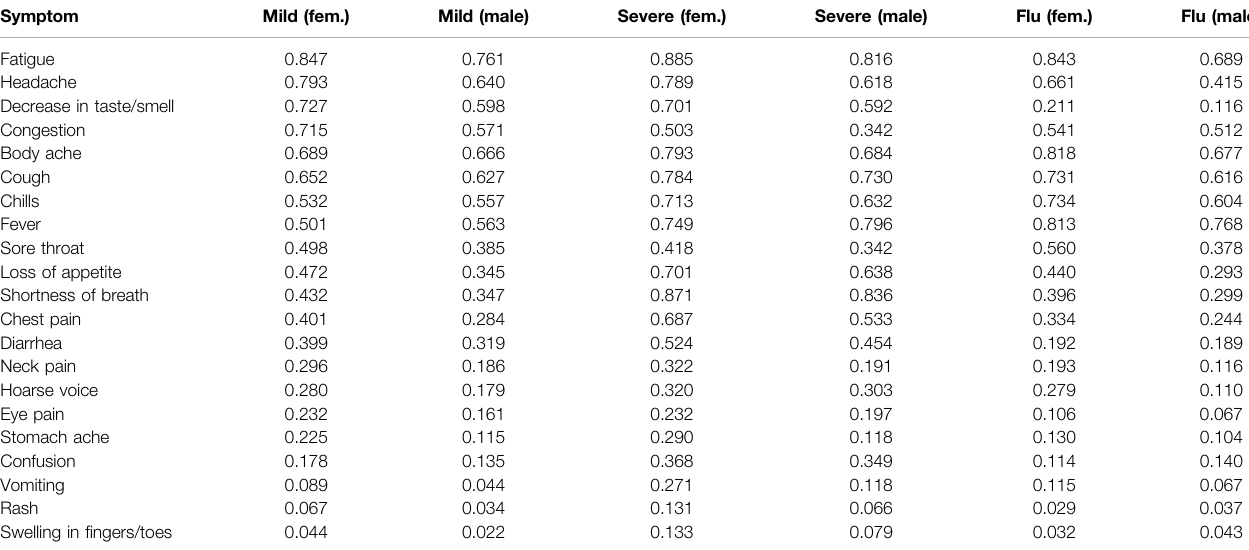
TABLE 1 | Prevalence of symptoms (expressed as a fraction), for COVID-19 (mild/severe) and fl u, for male and female participants. Symptom Mild (fem.) Fatigue